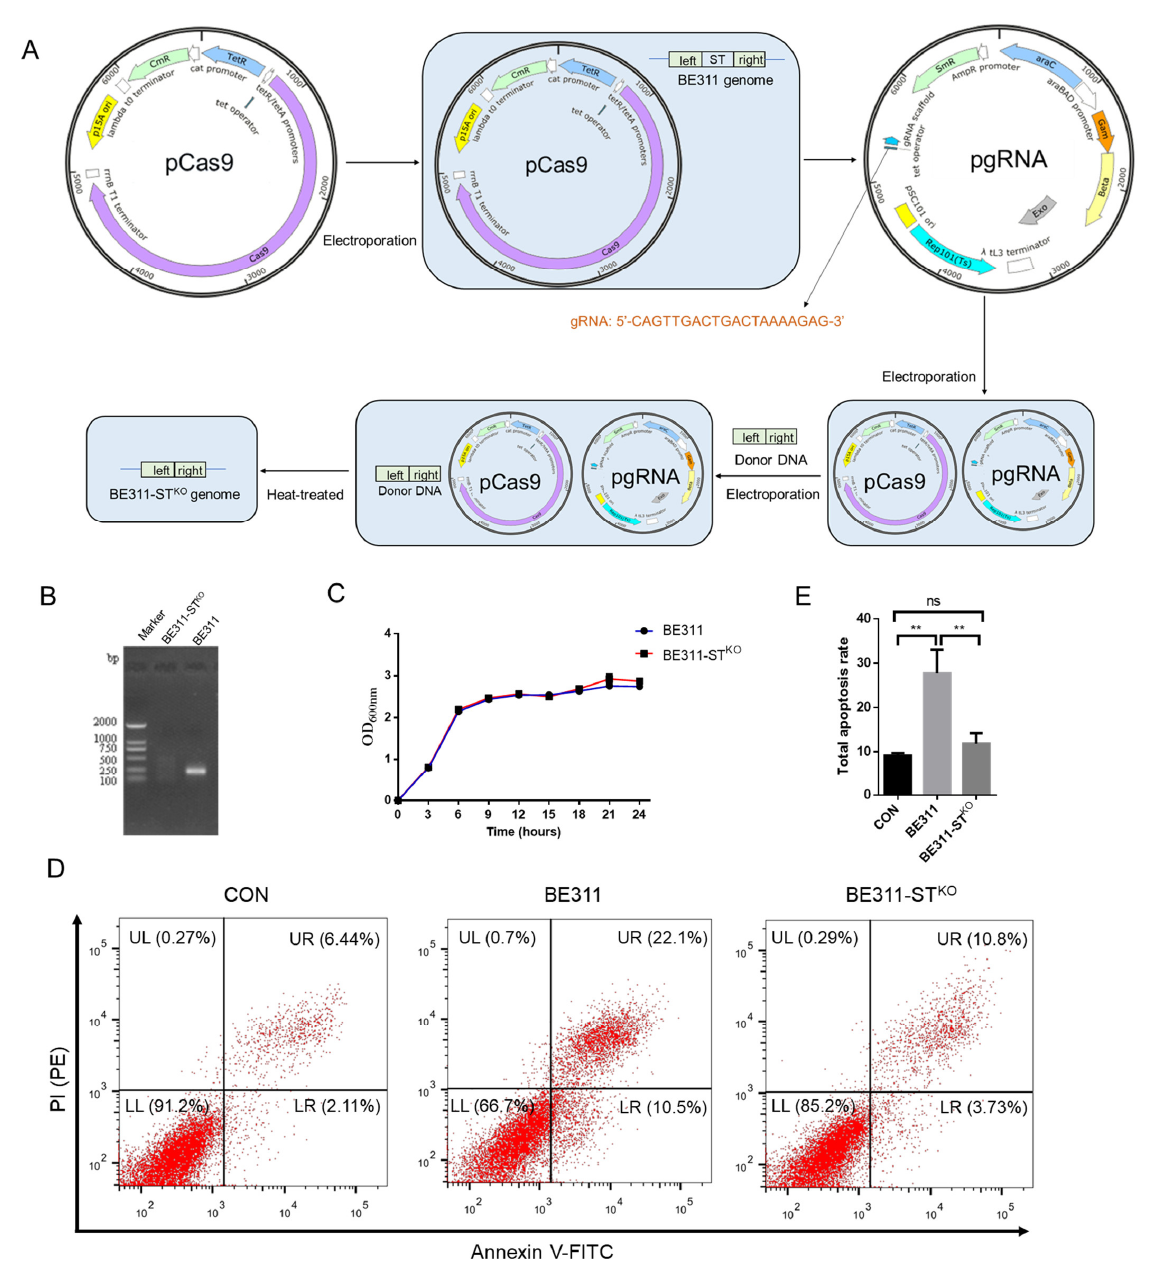
Figure 4. Construction and analysis of BE311-ST KO . ( A ), The knock-out process of ST gene in BE311. ( B ), Amplification of ST gene in wild-type and ST - knock-out BE311 strains. ( C ), The growth curve of BE311 and BE311-ST KO strains within 24 h. ( D ), IPEC-J2 cells were challenged with BE311 or BE311-ST KO for 6 h. Then the cellular apoptosis was examined by flow cytometry. ( E ), The total apoptosis rate in IPEC-J2 cells challenged with BE311 or BE311-ST KO for 6 h. ** p < 0.01, ns, no sig- nificant difference.